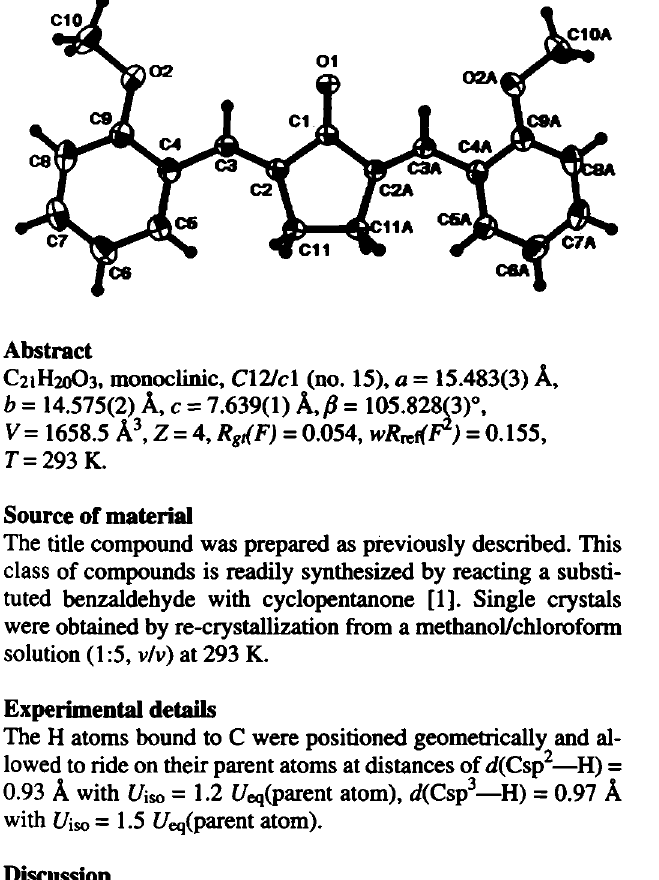
Table 2. Atomic coordinates and displacement parameters (in Â 2